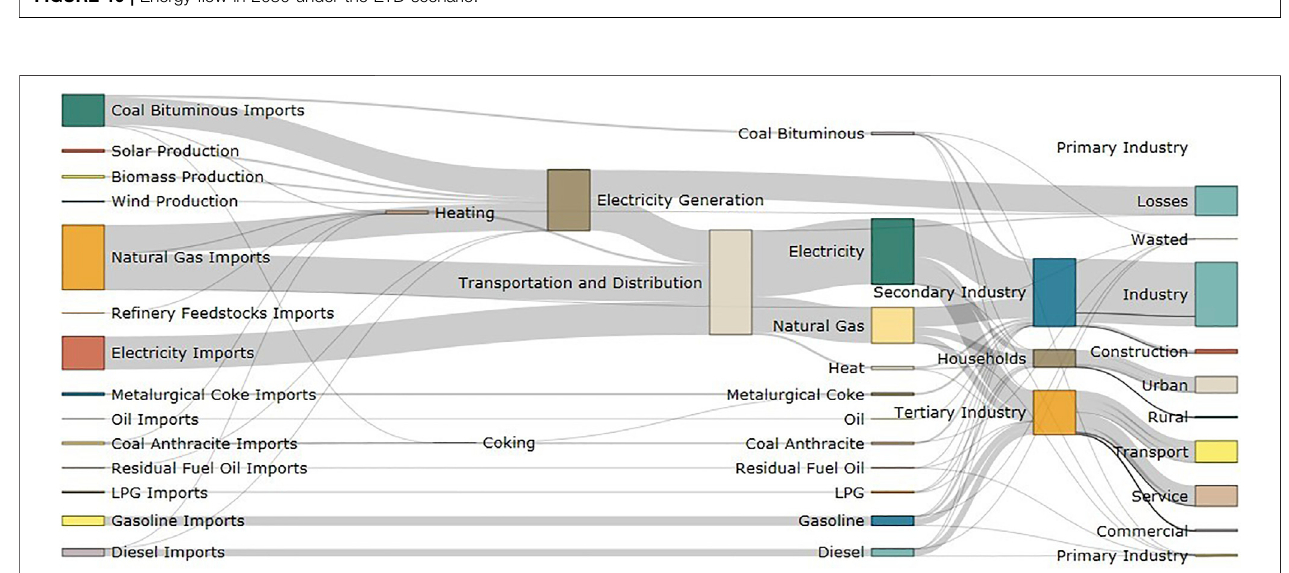
FIGURE 10 | Energy fl ow in 2030 under the ETD scenario.